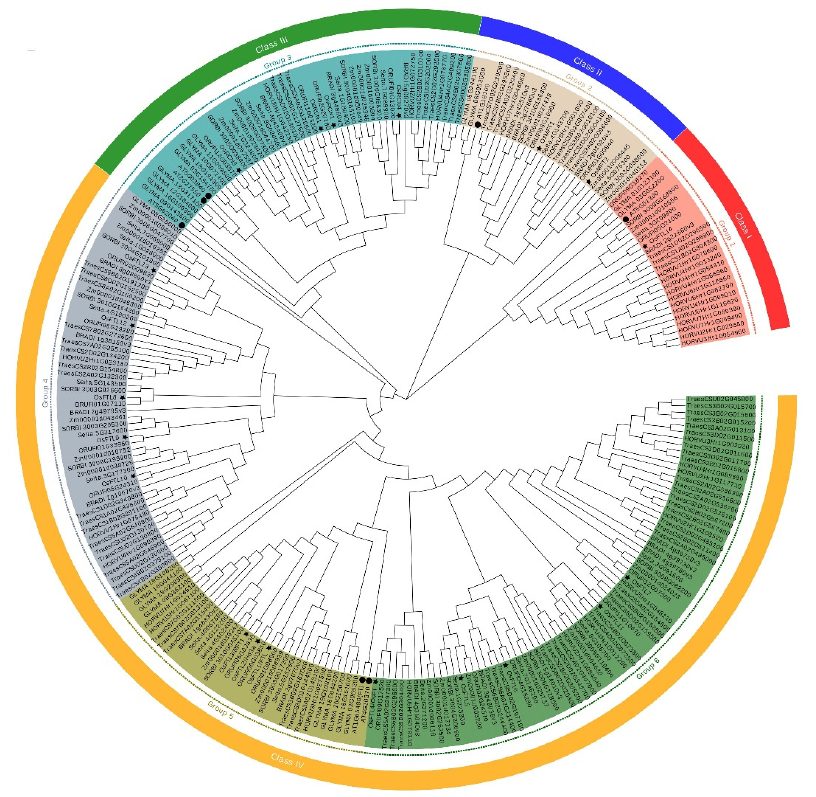
Figure 4. Phylogenetic analysis of PEBP-domain-containing proteins from crops. Phylogenetic tree among 262 PEBP proteins from rice, maize, wheat, sorghum ( Sorghum bicolor ), barley, millet ( Setaria